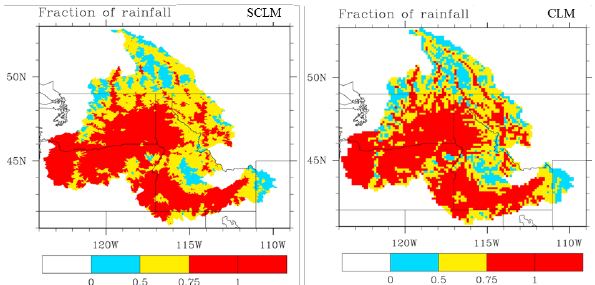
Figure 4. Climate regions based on model simulated rain- fall/snowfall partitioning. Table 1. The portion of areas within three climate regimes (km 2 ) . SCLM Figure 5. Seasonality of runoff and soil water over the climate re- gions. Note that soil water is included here because it is closely related to the runoff